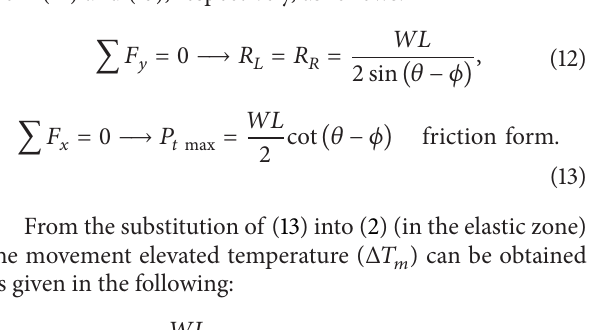
Equilibrium after